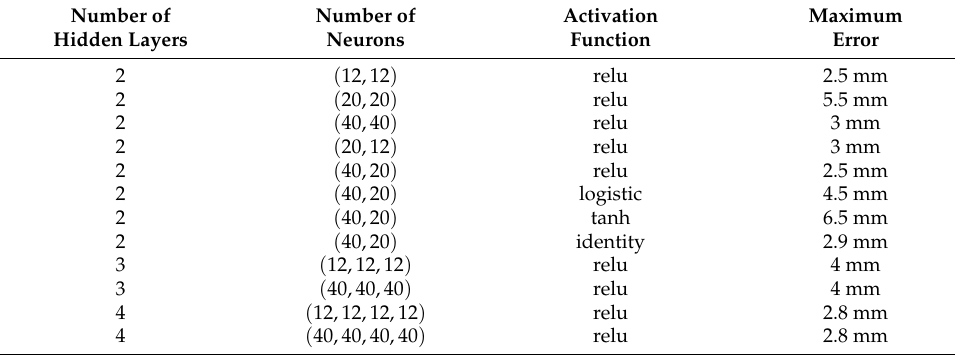
Figure 15. MLP approximation of sequence { 2,2,2,1,2,1,1,1 } compared with the reference solution (displacements × 10 for visualization). Table 1. Results for different choices of hyper-parameters for the neural